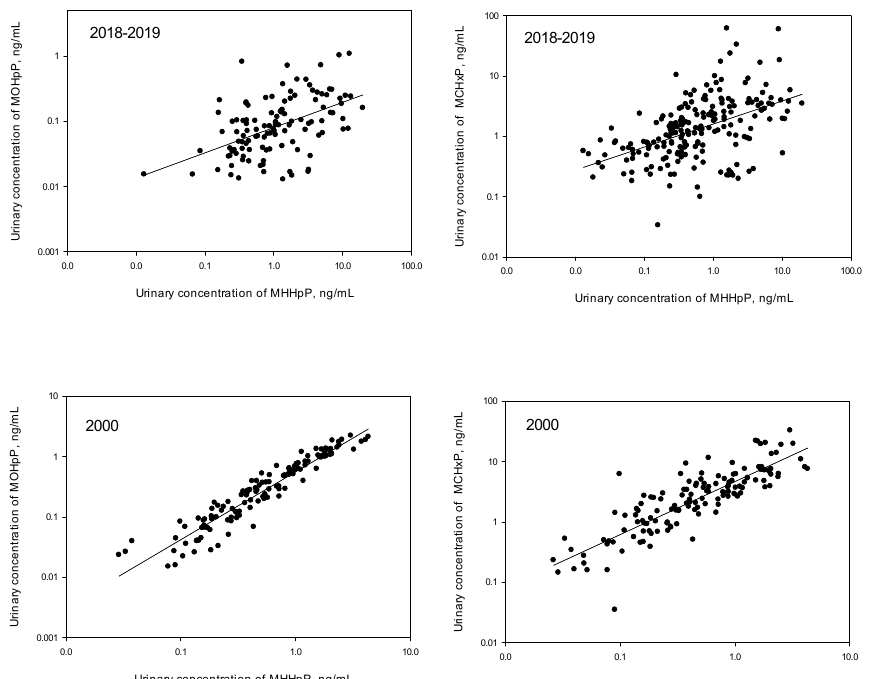
Figure 3. Correlation analyses of urinary concentrations of the metabolites of diisoheptyl phthalate (only the concentrations above the limits of detection are shown).